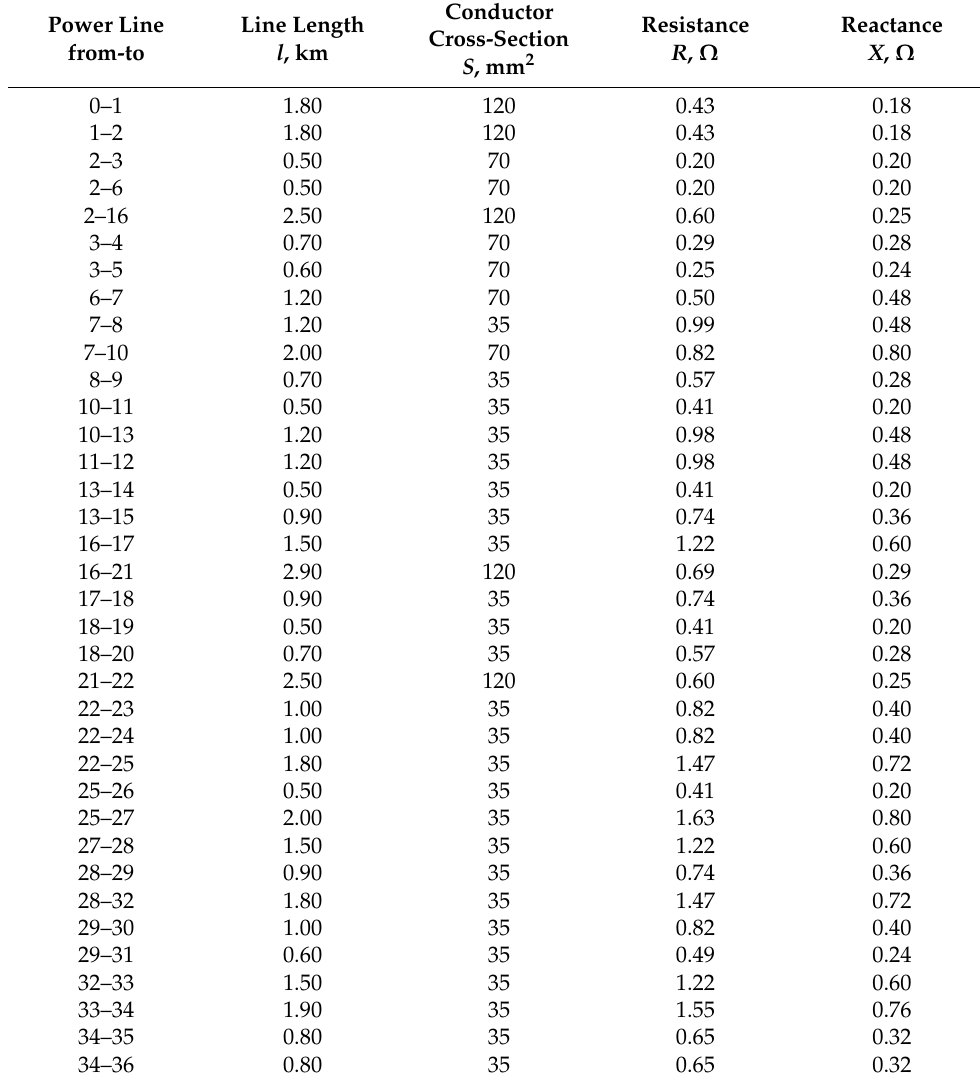
Table 1. Parameters of the individual sections of the MV